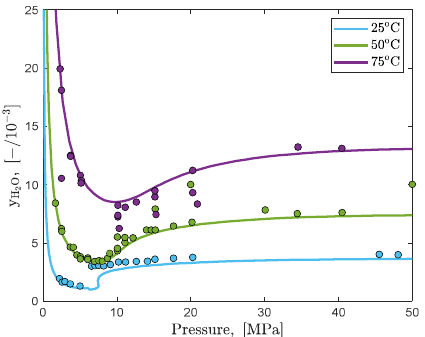
Figure 9. Mole fraction of water in the CO 2 -rich gas phase in a water-CO 2 mixture as a function of temperature and pressure. The discrete points are experimental data from [52], and the continuous lines are calculated by the simulator.